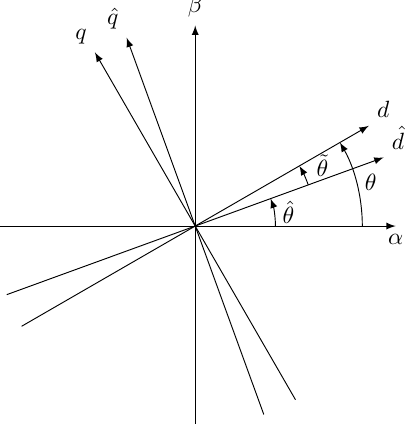
Figure 1. Relationship between the real coordinates and the estimated coordinates.